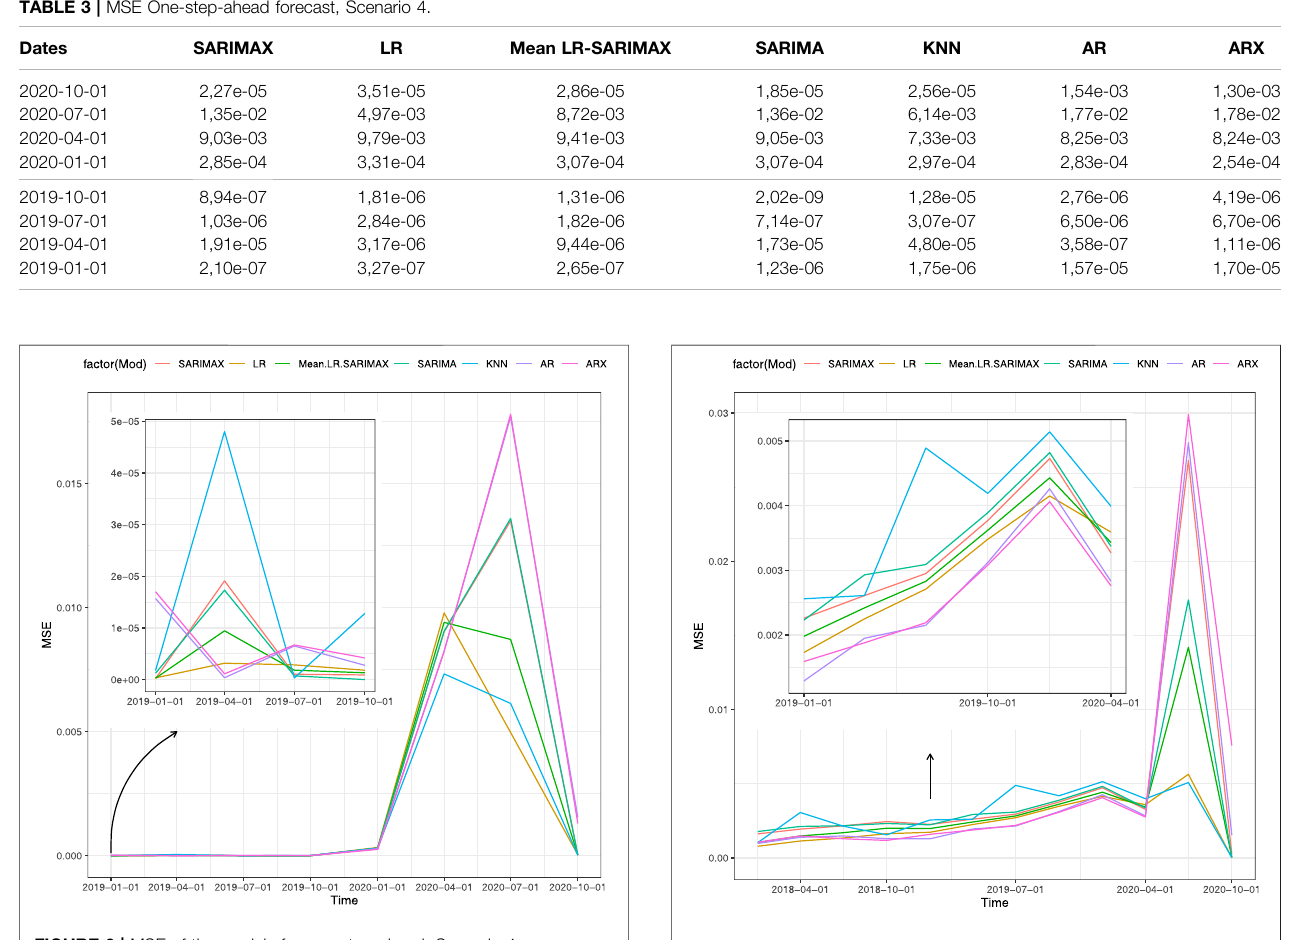
FIGURE 4 | MSE of the models for multi-step-ahead, Scenario 5, sensitiveness to the pandemic